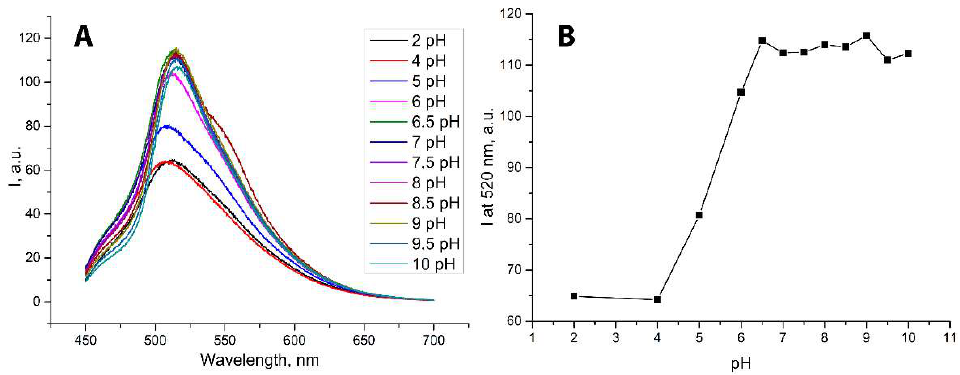
Figure 3. TEM ( A , B ), SEM ( C ) and confocal microscopy ( D ) images (λ ex = 405 nm, 410–695 nm scan range) of SLNs from 5 (0.01 mg/mL).